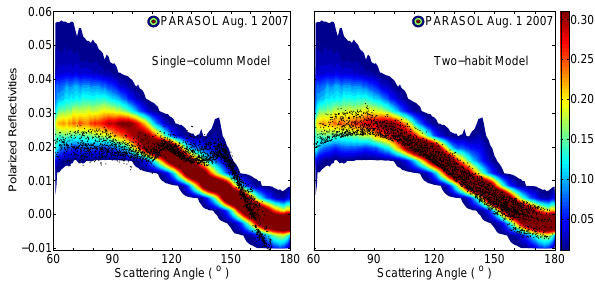
Figure 13. Comparisons between the normalized polarized reflec- tivities obtained from 1 day of PARASOL data over ocean (color contours) and calculations (black dots) based on the single-column model (left) and the two-habit model (THM,